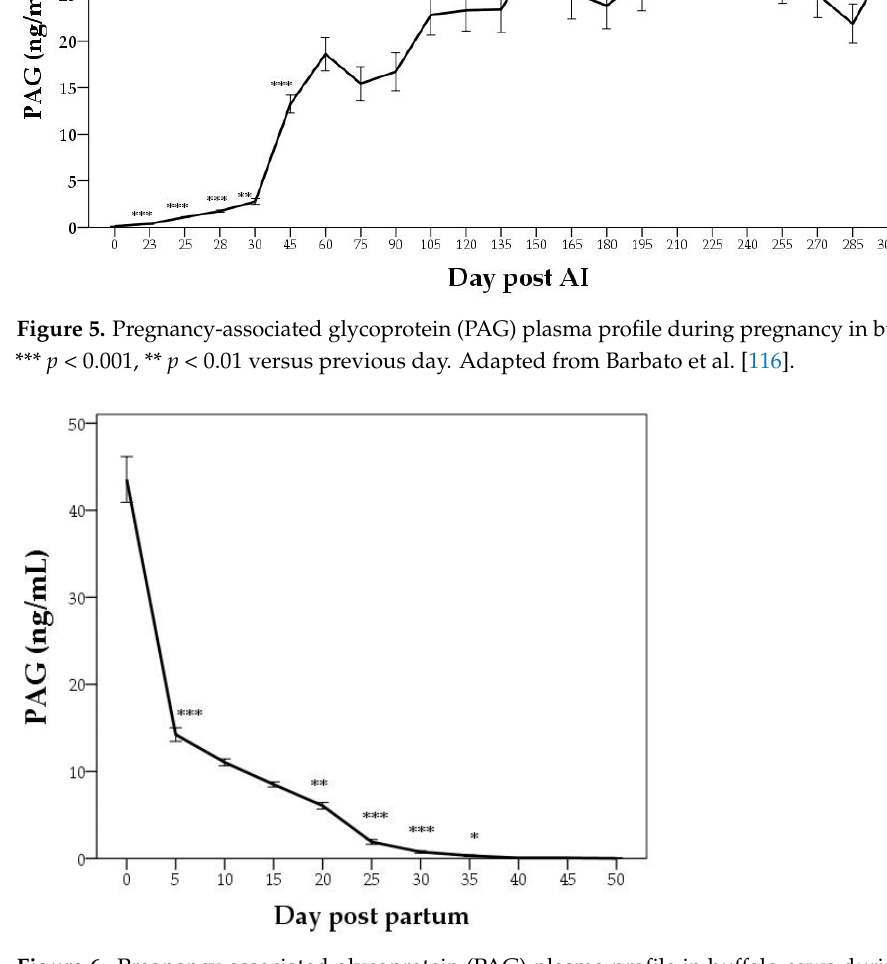
Figure 6. Pregnancy-associated glycoprotein (PAG) plasma profile in buffalo cows during the post- partum period. *** p < 0.001, ** p < 0.01, * p < 0.05 versus previous day. Adapted from Barbato et al. [116].